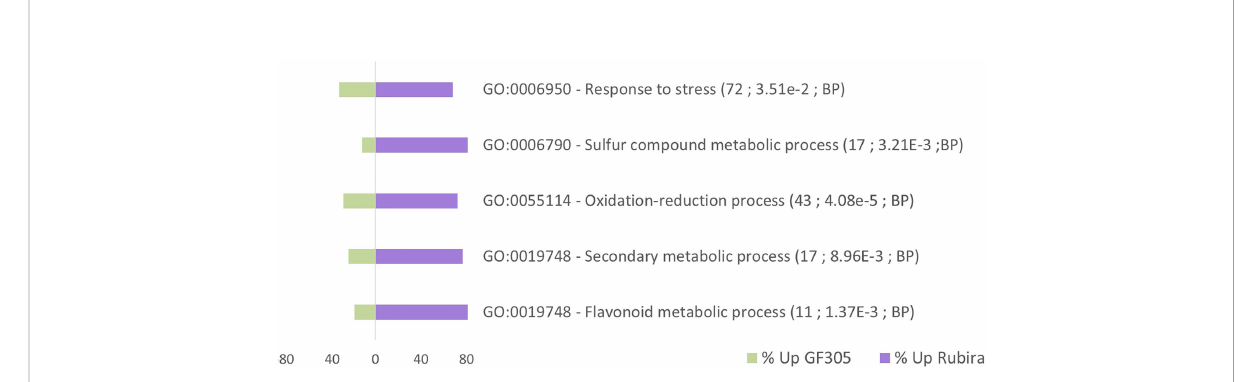
FIGURE 4 Gene Ontology (GO) enrichment analysis for the comparison of constitutive gene expression in the uninfested resistant Rubira compared to the susceptible GF305. Bars indicate the percentage of upregulated genes associated to GO terms. A total of 217 markers were mapped in this enrichment analysis. GO terms with at least a 1.5-fold over-representation and an enrichment adjusted p.value lower than 0.05 are presented. For each GO term, details are given in parentheses: (i) number of P. persica GO annotated genes, (ii) adjusted p.value of enrichment, (iii) GO groups (BP: Biological